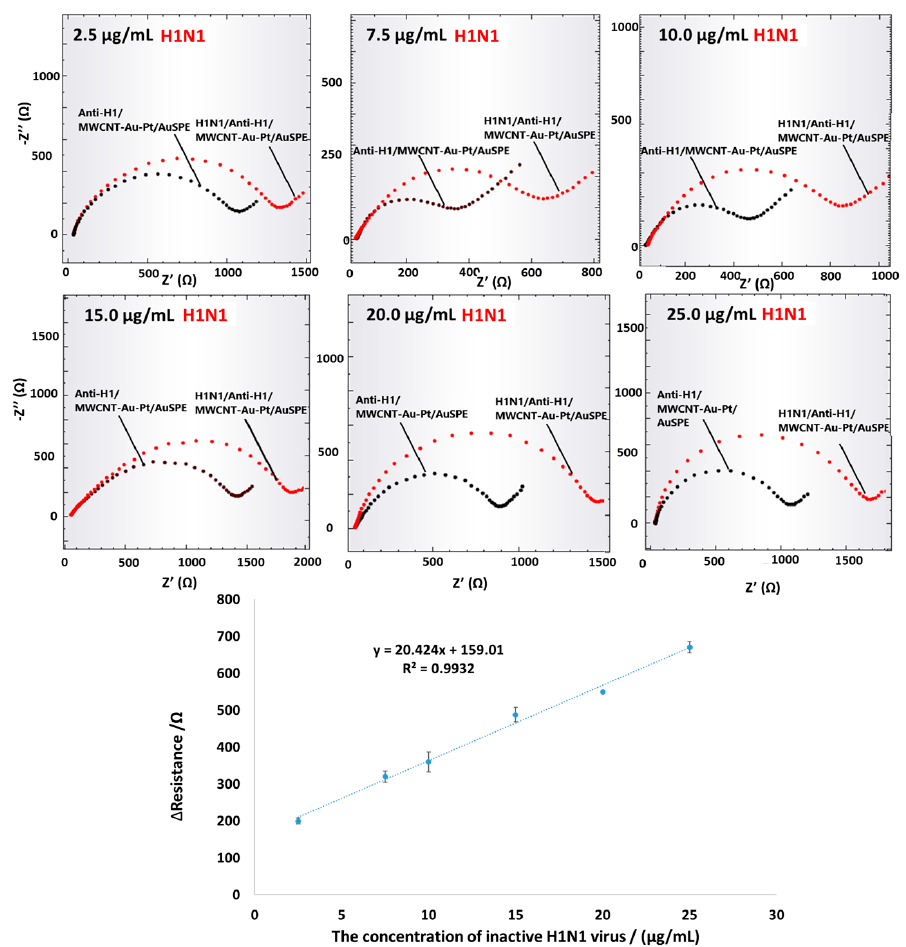
Figure 6. Nyquist plots and calibration graph of developed immunosensor. EIS measurements were performed in 50 mM pH 7.4 phosphate buffer including 10 mM [Fe(CN) 6 ] 4 − /[Fe(CN) 6 ] 3 − as a redox probe indicator, in the frequency range of 0.1 Hz–10 kHz at a potential of 0.10 V.